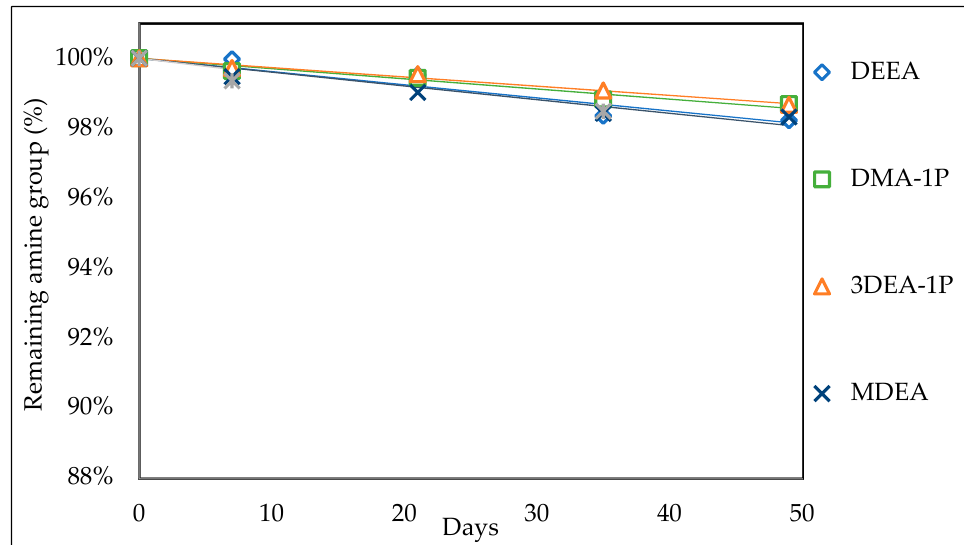
Figure 4. Remaining amine group concentration in aqueous amine solutions, with solid lines representing the model results; unloaded amine wt.% = 30; CO 2 loading ≈ 0.1.